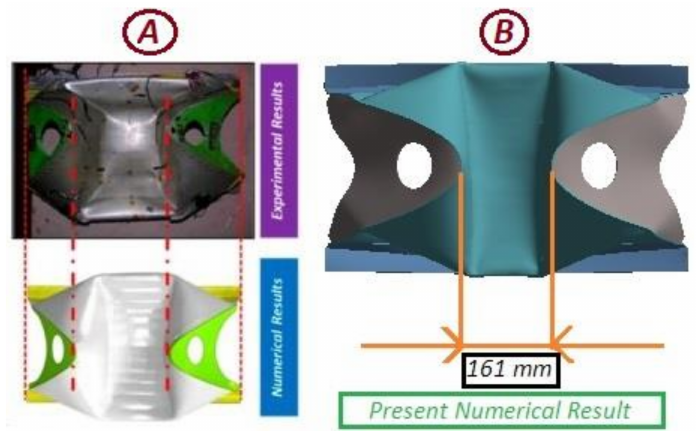
Figure 4. Post impact permanent deformation. ( A ) Experimental and numerical results from the reference. Reprinted with permission from Refs. [25,34]. 2020 [25] and 2019 [34], Di Caprio et al.; ( B ) Present numerical